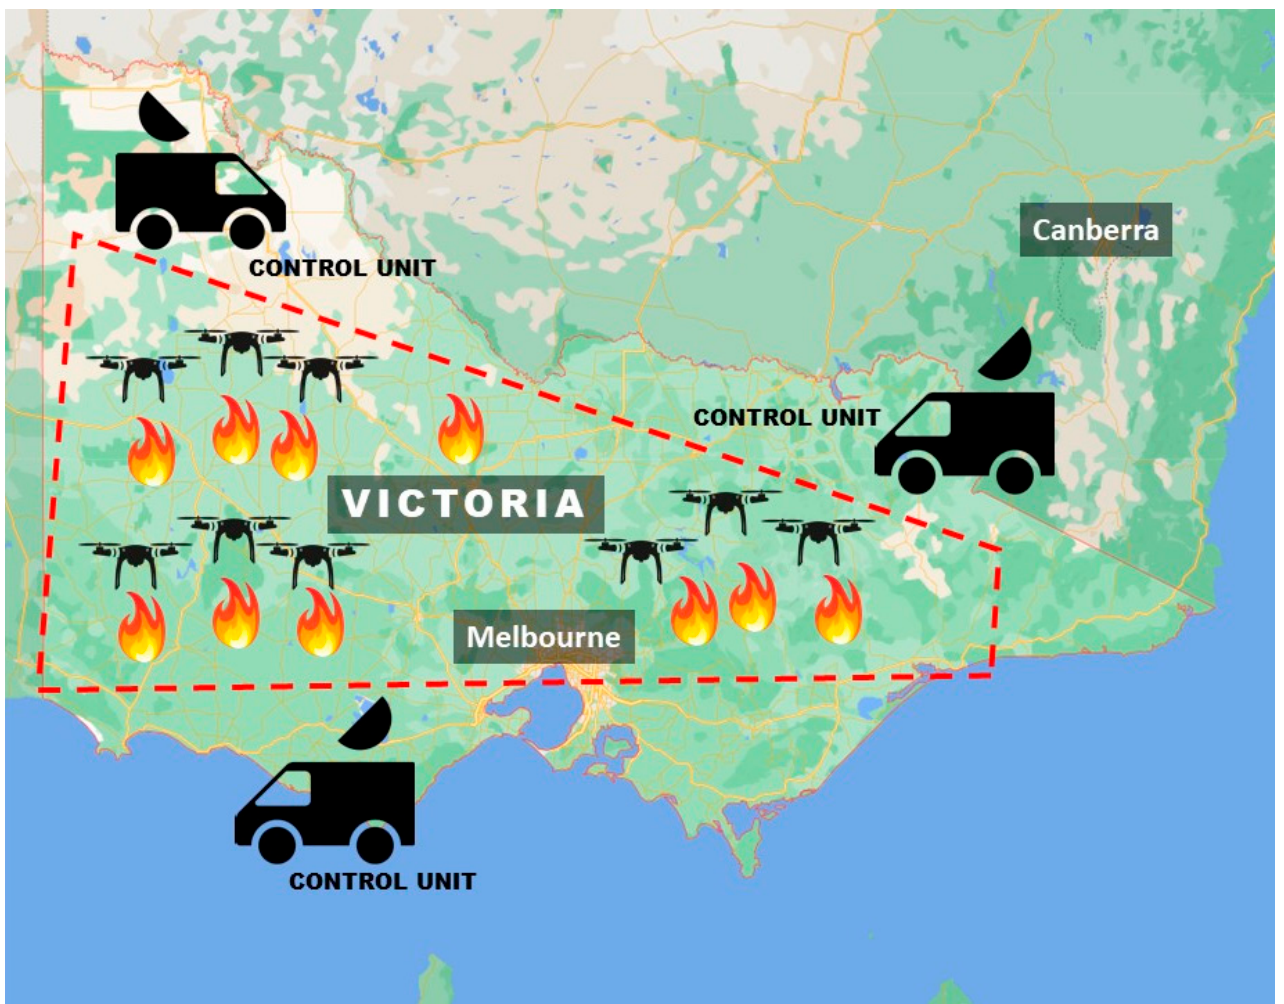
Figure 3. UAV ‐ based bushfire assessment in the Victoria region. Figure 3. UAV-based bushfire assessment in the Victoria region. Fire 2021 , 4 , x